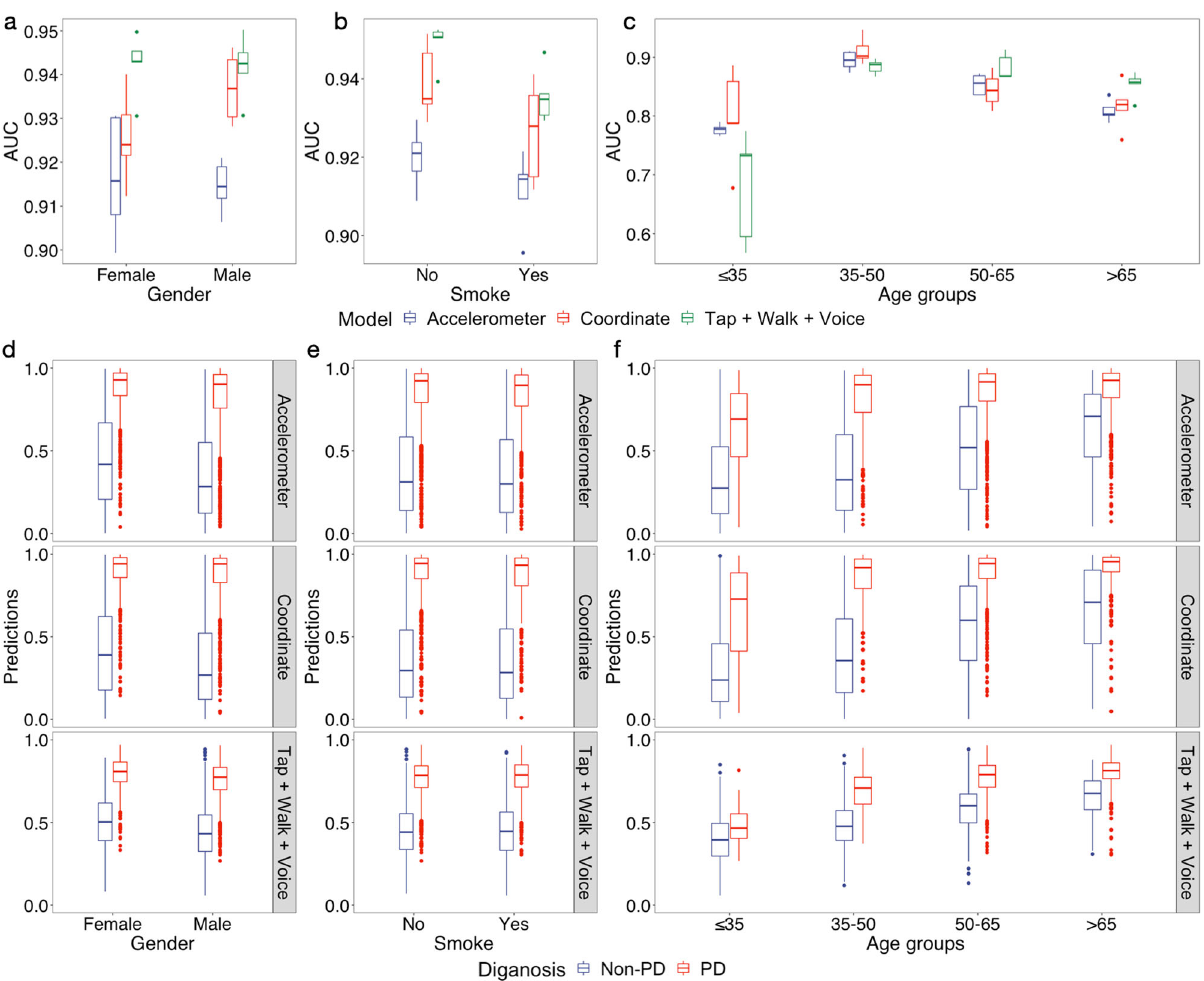
Fig. 5 Performance comparison of different demographic groups. a – c Performances in AUC and the predictions in different groups of data, separated by gender, smoking and age. d – f Distribution of prediction scores of Non-PD and PD for different gender, smoking, and age comfortable reading and writing on an iPhone in English. Participants needed to take a quiz of the study aims, participants right and data sharing, and were required to complete an e-consent process and sign. They were also asked for an email for veri fi cation. Participants can submit their records three times a day. Participants with PD were asked to fi nish the tests in three scenarios: (1) immediately before taking their medication; (2) after taking their medication (when they are feeling at their best); (3) at some other time. And those with non-PD can complete at any time. Deep learning architecture and training procedure . Similar neural network structures were built for accelerometer and coordinate data models except for channel lengths according to different sizes of input data: 2500 for the accel- erometer model and 800 for the coordinate model. The network contains seven convolutional layers, seven max-pooling layers, and one fully connected layer activated by a sigmoid function for the output (Figs. 2a, 3a). We performed cross-validation by partitioning the mPower samples into the training set (75%) and the testing set (25%) at the individual level with a random seed. Furthermore, half of the training samples were used to train the model and the other half were used in the validation process for hyperparameter tuning. During each training process, the binary cross-entropy H b ( p ) was applied as the loss function for selecting the best epoch, the parameters used in that epoch would then be stored for validation. The loss function is de fi ned as: